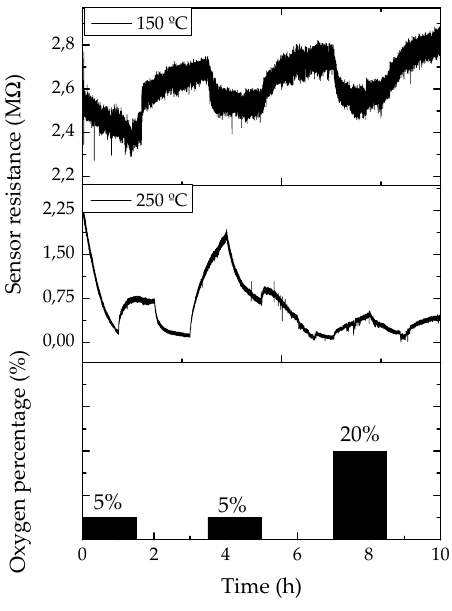
Figure 5. Resistance evolution of a single gallium oxide nanowire-based sensor towards different pulses of oxygen in a synthetic air ambient at 150 and 250